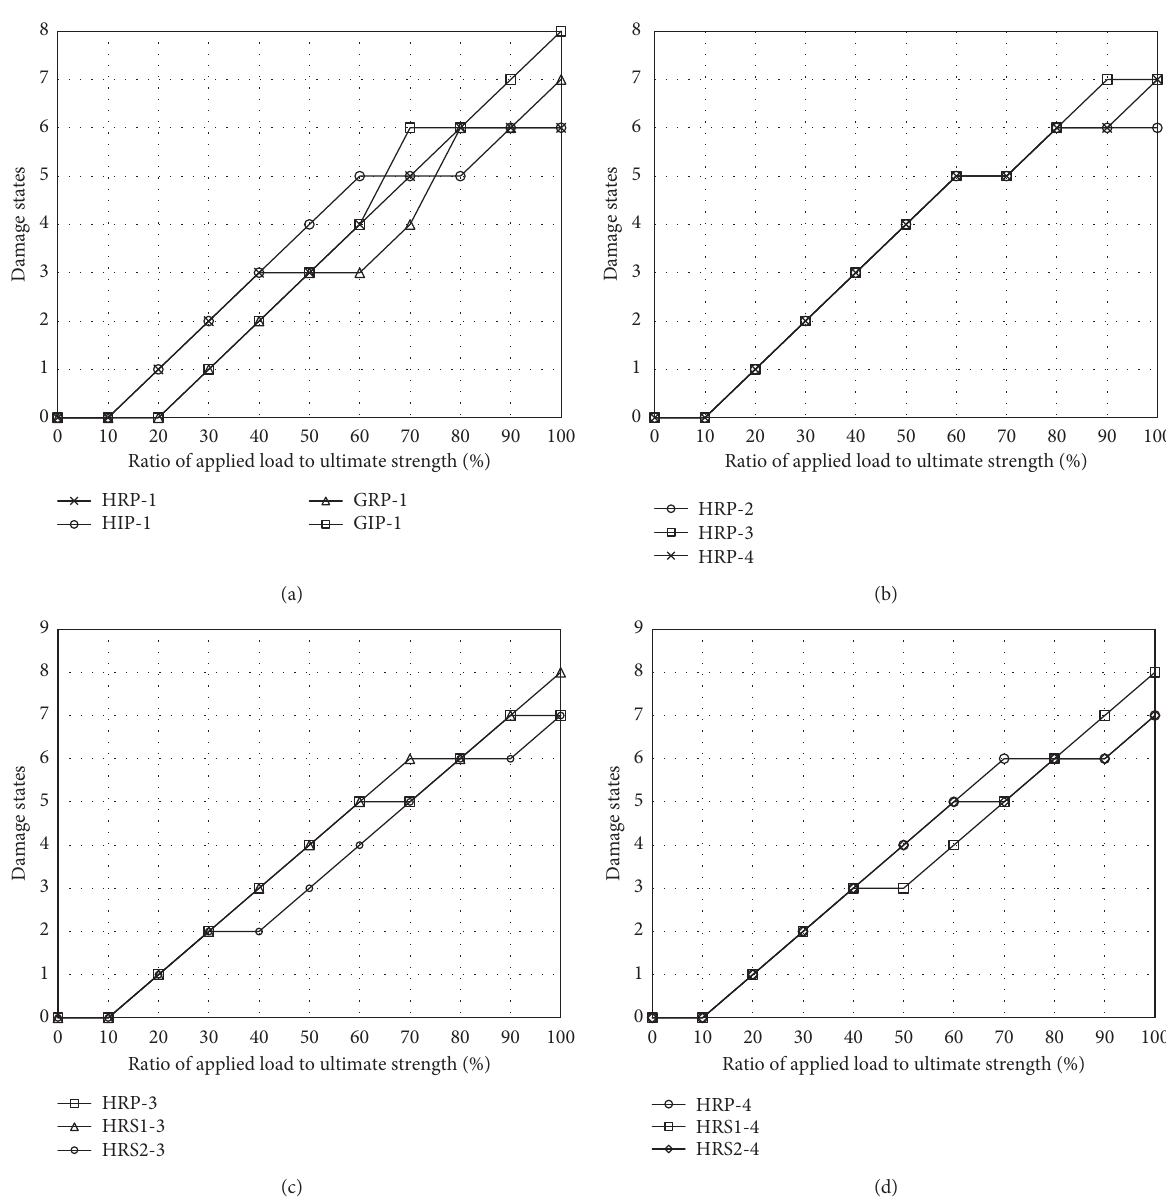
Figure 8: Damage states according to applied load. (a) Specimens with tensile strength of strands as a variable; (b) specimens with number of strands as a variable; (c) specimens using three strands for varying anchorage zone reinforcement types; (d) specimens using four strands for varying anchorage zone reinforcement